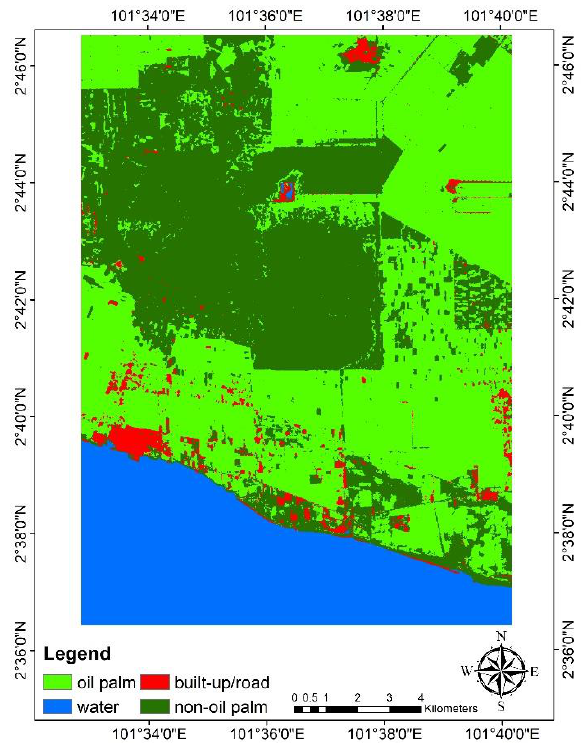
Figure 3. SVM classified image using